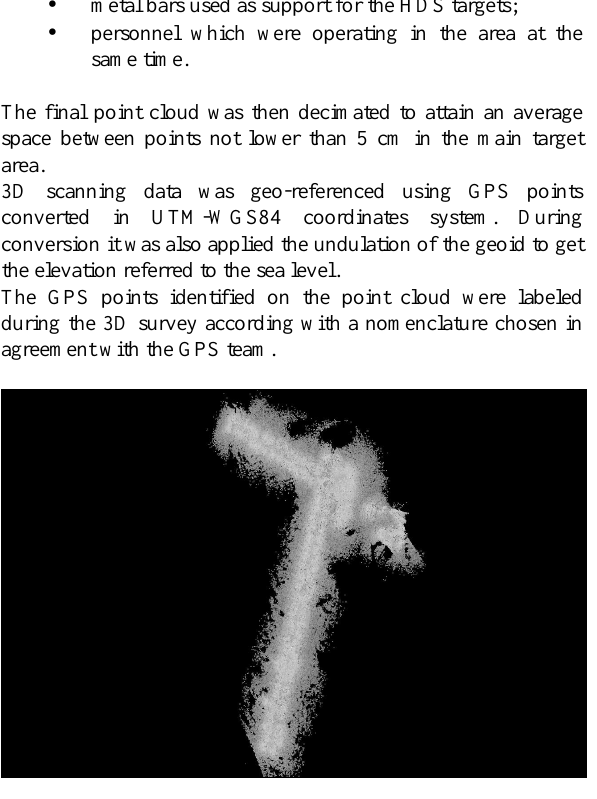
Figure 5. Final point cloud after alignment (grey scale)